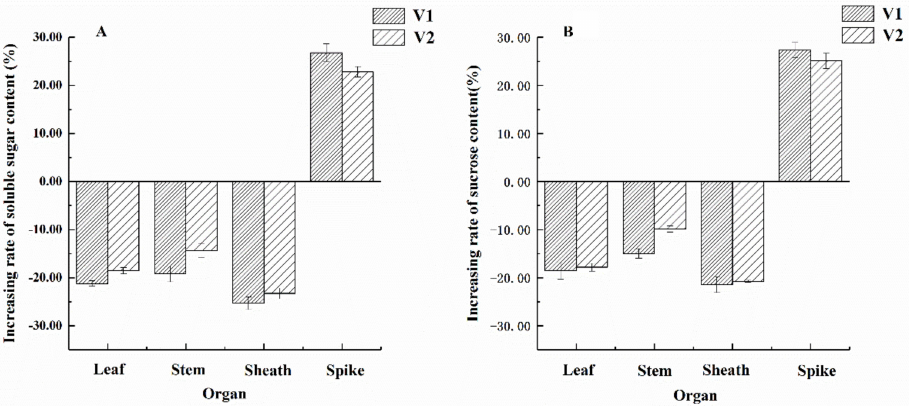
Figure 4. Changes of soluble sugar and sucrose contents in di ff erent organs at anthesis under exogenous 6-BA treatment and the control in wheat. The e ff ects of 6-BA on soluble sugar content ( A ) and sucrose content ( B ) during 2016–2018,